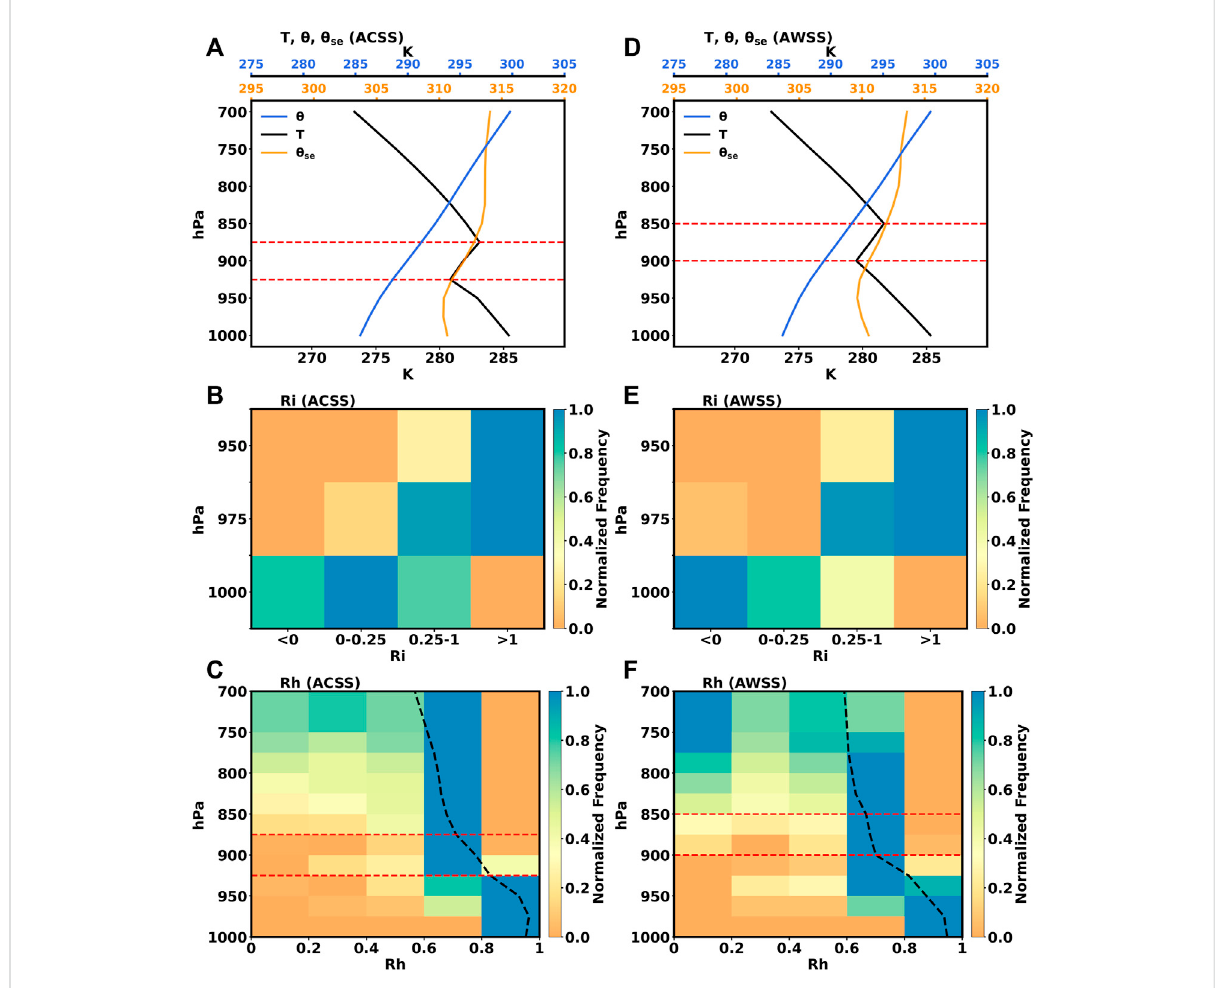
FIGURE 9 Composite pro fi les, the bulk Richardson number, and relative humidity frequency distribution concurrent with fog with ACSS (A – C) and fog with AWSS (D – F) : temperature ( T , black line, in K), potential temperature ( θ , blue line, in K), saturated equivalent potential temperature ( θ se , orange line, in K), the bulk Richardson number ( Ri , shaded), and relative humidity ( Rh , shaded). The red dashed lines denote the inversion